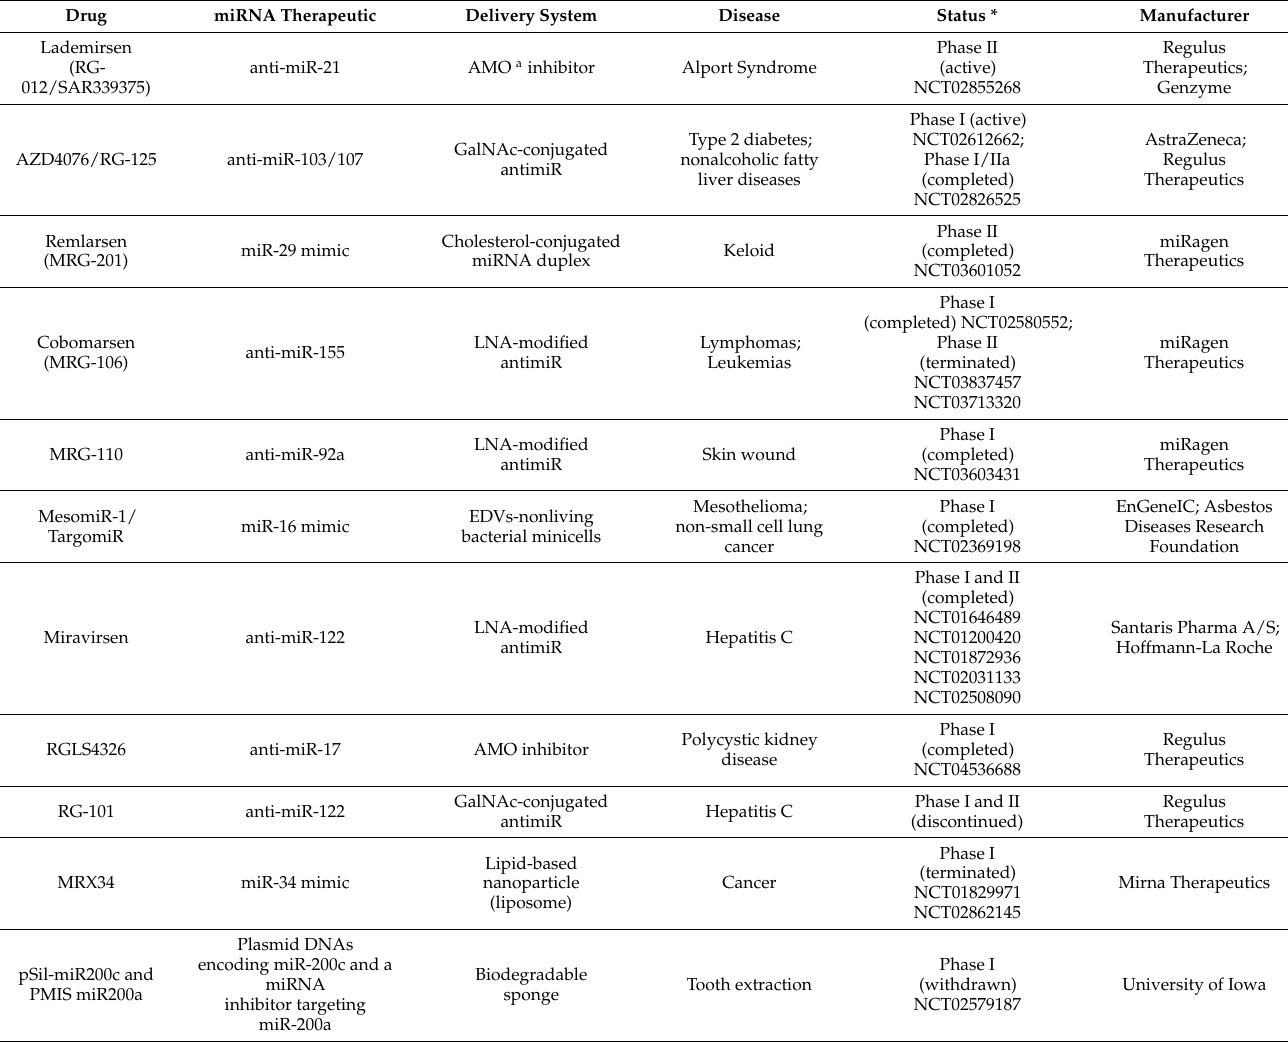
Table 1. Status of miRNA therapeutics-based clinical trials in